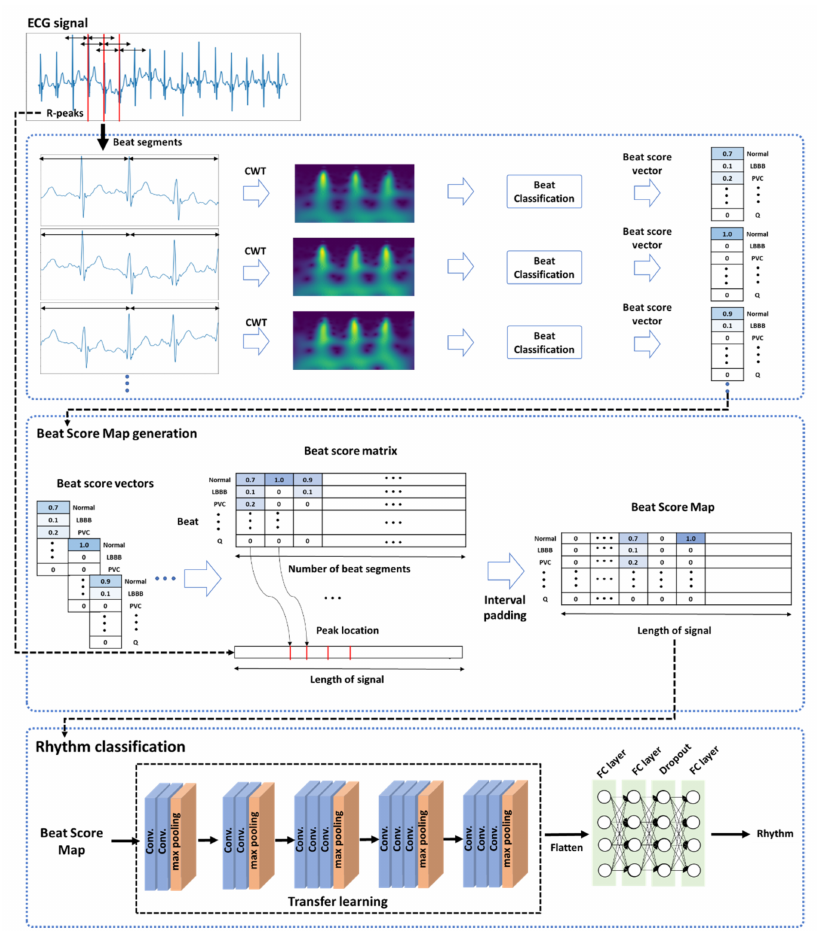
Figure 1. General overview of the proposed